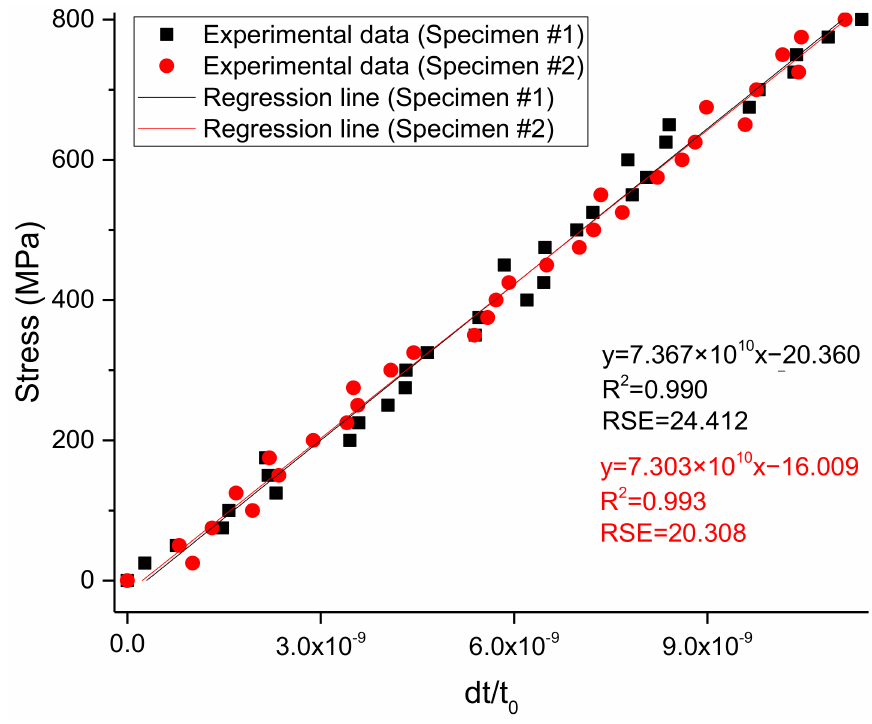
Figure 10. The dt / t 0 vs. stress graphs obtained from the tensile tests for two rail specimens.